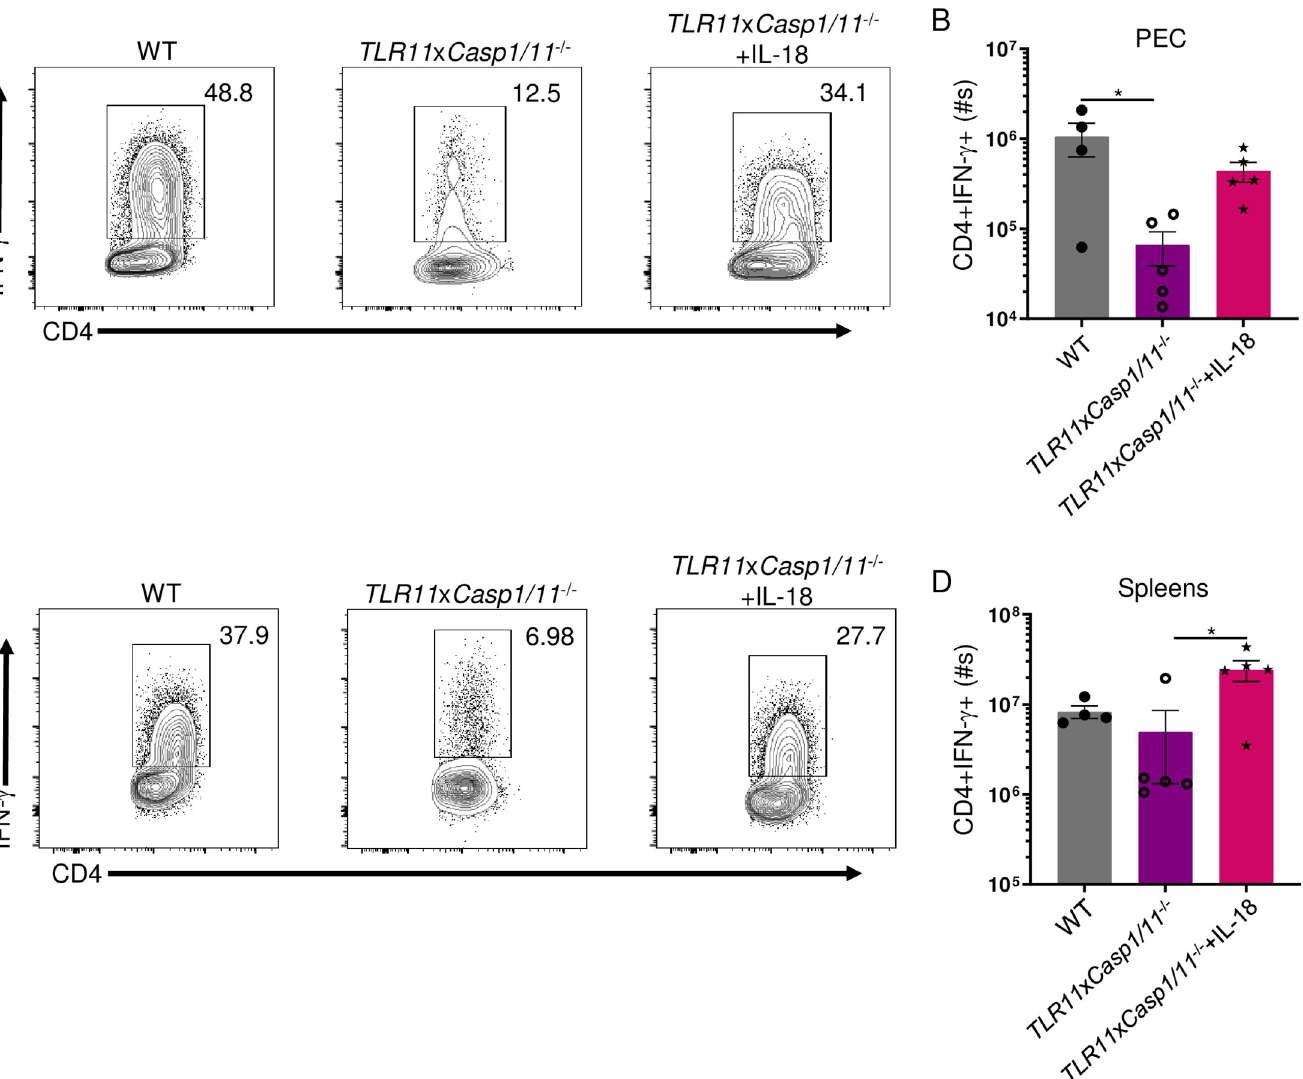
Fig 5. IL-18 is sufficient to augment T H 1-derived IFN- γ responses in the absence of TLR11. ( A, C ) WT and TLR11 x Casp1/11 -/- mice were infected with 20 cysts of T . gondii . TLR11 x Casp1/11 -/- mice were administered 200 ngs of IL-18 i.p. on days 0, 1, 2, and 3. PECs (A) and spleens (C) were harvested and IFN- γ production by CD4 + T cells was analyzed by flow cytometry. ( B , D ) Absolute quantification of CD4+IFN- γ + cells in the PECs (B) and spleens (D) were analyzed on day 8 following infection. Results are representative of three-independent experiments involving at least 3 mice per group. Statistical analyses were done using one-way ANOVA with a Tukey’s multiple comparison test, � P < 0.05. Error bars, standard error mean.